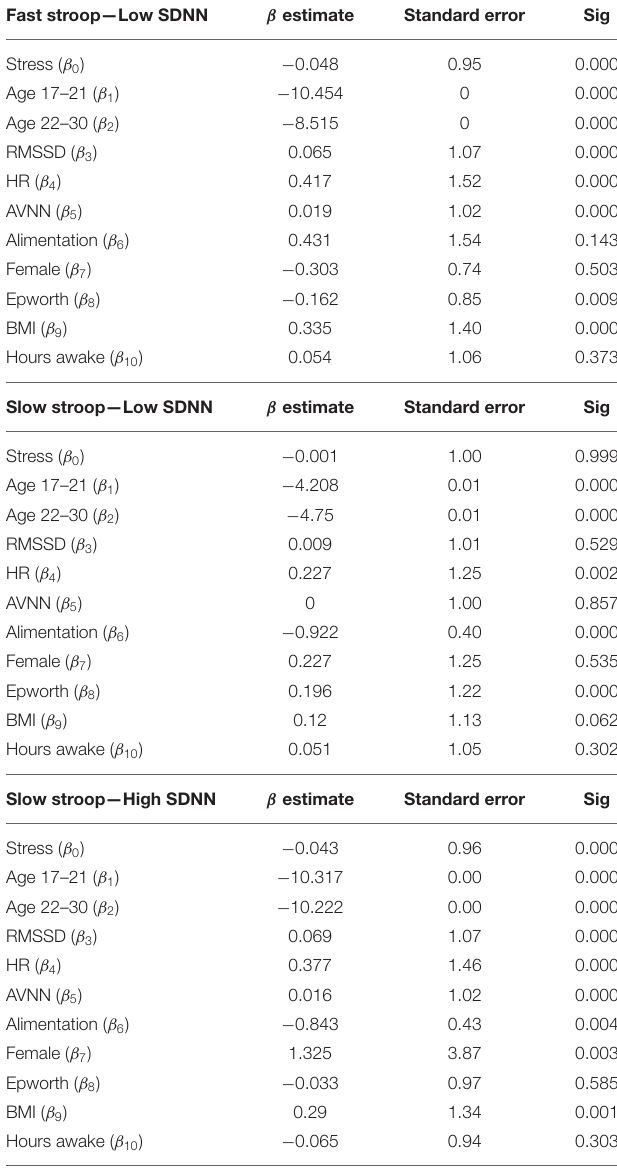
TABLE 3 | Results from multivariate logistic regression model containing all explanatory variables (full model). Fast stroop—Low